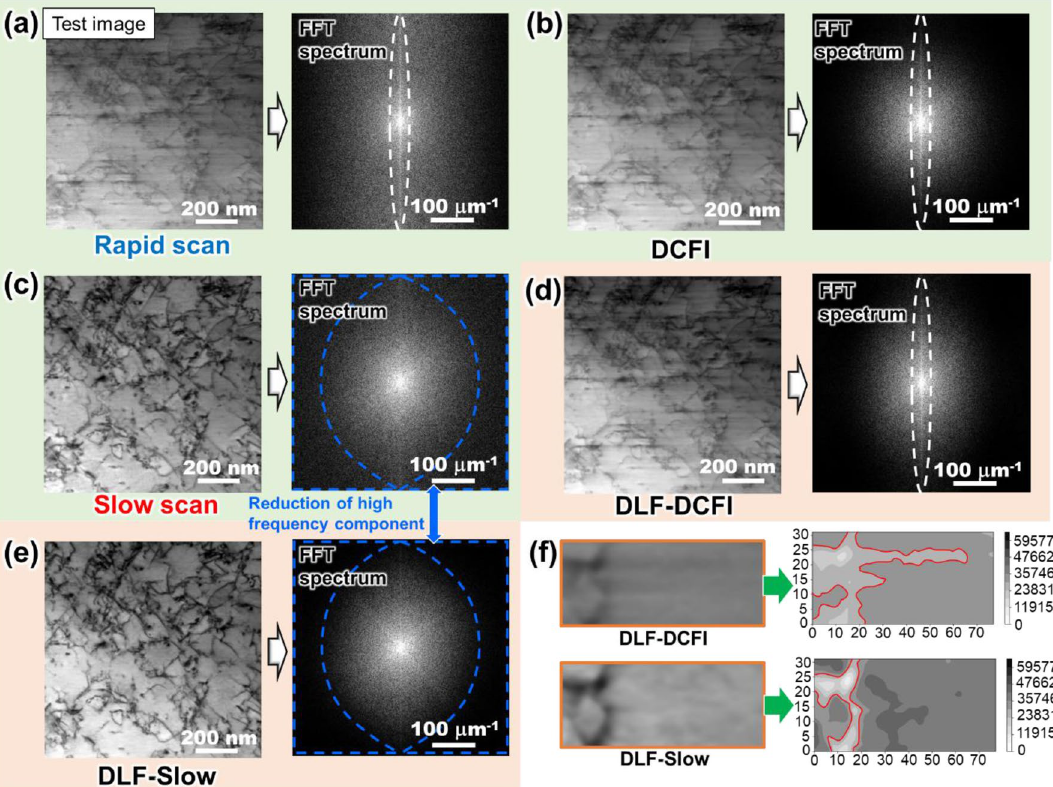
Figure 3. Sample STEM images selected from a validation dataset of 50 frames × 16 FOVs. The rest of results are displayed in Supplementary information B. ( a ) Rapid scan, ( b ) DCFI, ( c ) slow scan, DL filtered rapid scan supervised by ( d ) DCFI images (DLF-DCFI), and ( e ) slow scan images (DLF-Slow) are represented. This figure also shows FFT spectra of those images, where the vertical pattern in FFT indicating the unidirectional blurring is circled by broken line. ( f ) Contour plot of the partial DLF-DCFI image demonstrates that the blurring remains, while the DLF-Slow completely removes it. Note that all the FFT spectrum images displayed in this paper are obtained by using DigitalMicrograph (Gatan, Inc.) after applying the Hanning